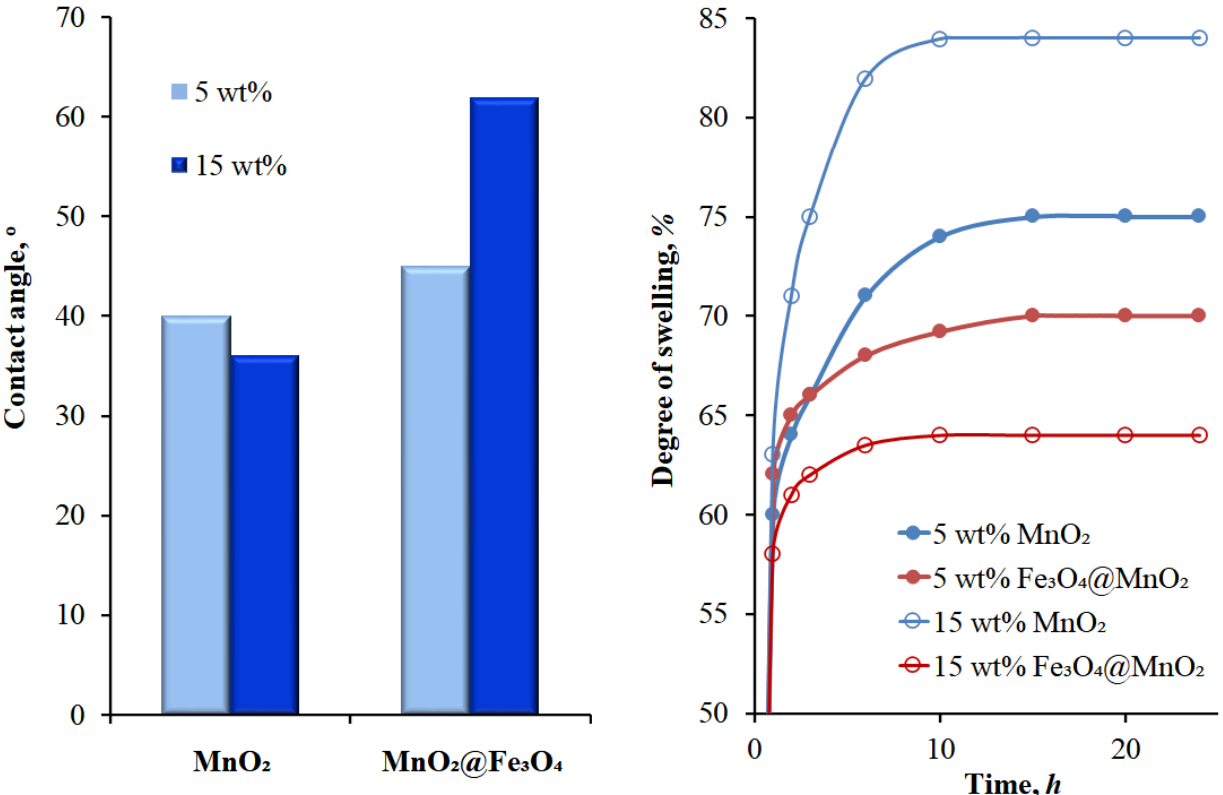
Figure 5. The changes in contact angle ( left panel ) and the kinetic of swelling ( right panel ) for alginate membranes filled with neat MnO 2 and MnO 2 @Fe 3 O 4 mixed fillers at 5 and 15 wt.%, respectively.